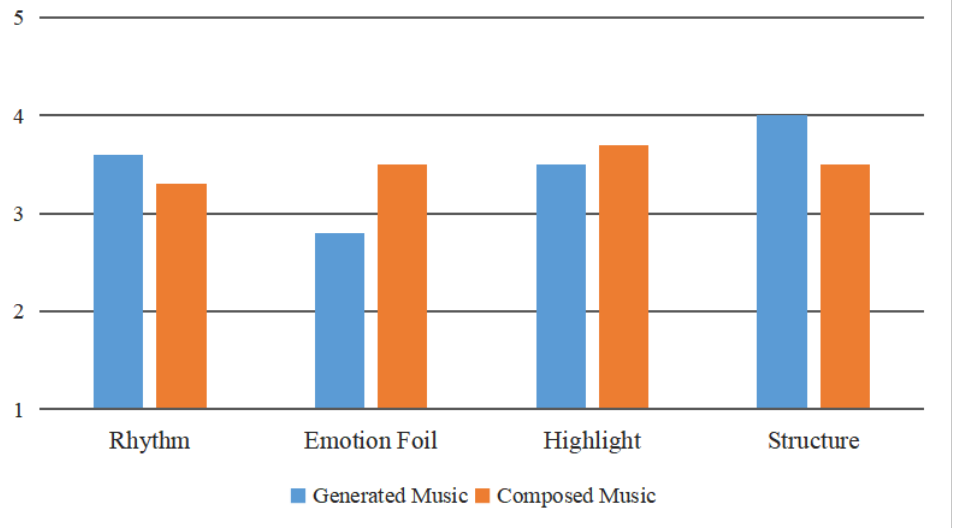
Figure 7. The average result from the expert evaluation group on two kind of music pieces on different indicators of night scene.